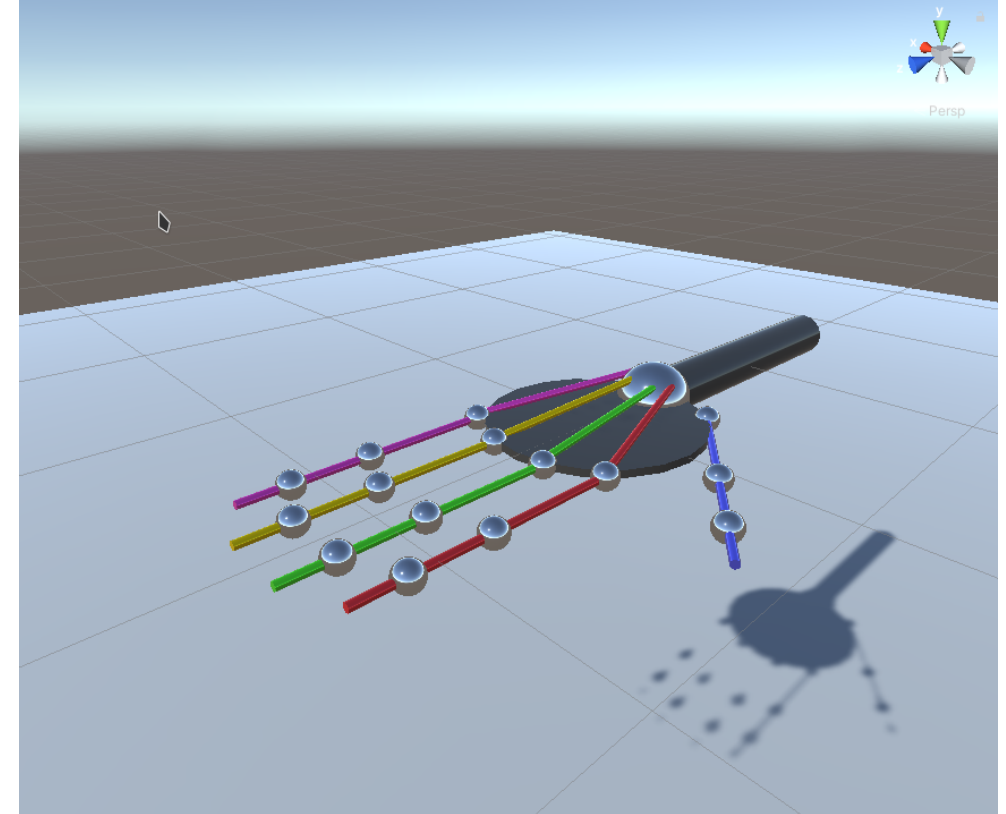
Figure 4. Visual representation of the